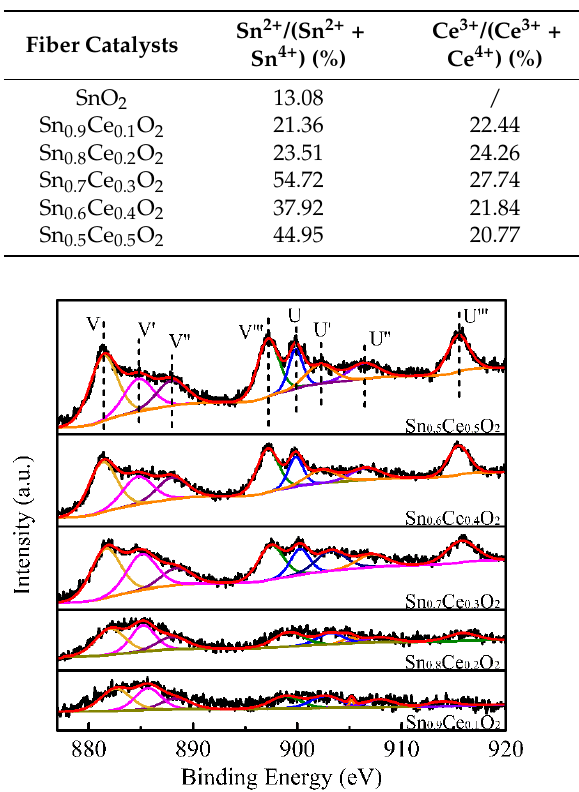
Figure 10. XPS spectra in the Ce 3d region of the Sn x Ce 1-x O 2 fiber catalysts.